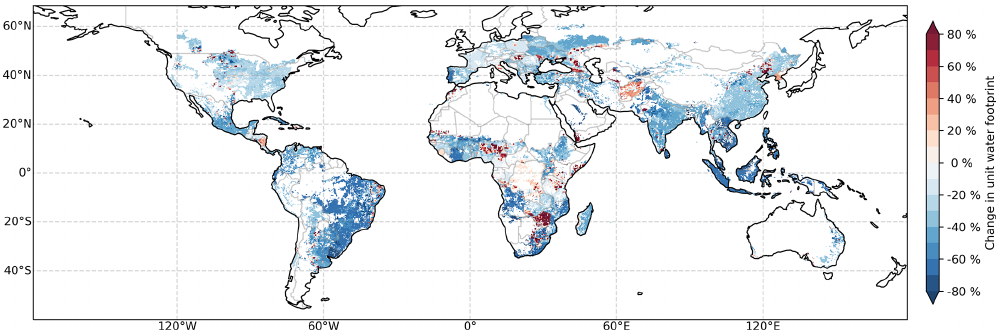
Figure 7. Relative change in unit water footprint of maize from the average of 1986–1990 to the average of 2012–2016 at 5 × 5arcmin resolution.